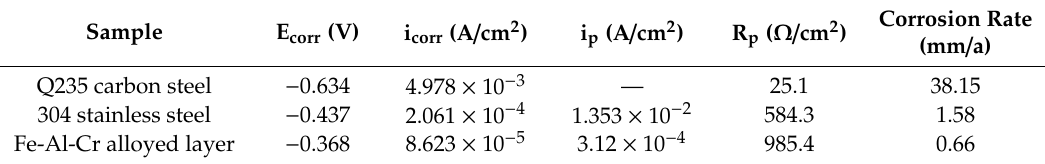
Table 1. Calculation results of polarization curves of samples in a 0.5 mol / L H 2 SO 4 solution.